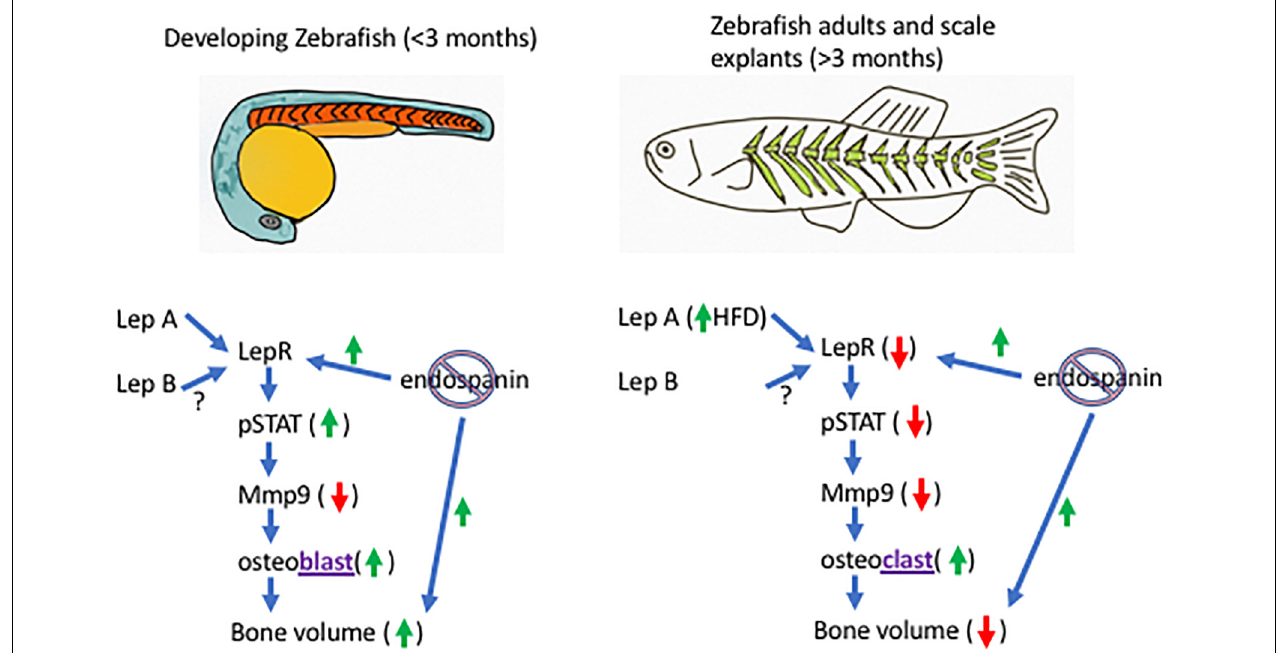
FIGURE 1 | Model of the endospanin modulation of leptin sensitivity in zebrafish. In developing zebrafish (left), endospanin knockout is predicted to increase bone volume through increased cell-surface leptin receptor expression (LepR), increase leptin signaling [through increased phosphorylation of signal transducer and activator of transcription (STAT)], decrease expression of matrix metalloproteinase 9 (Mmp9) and increase the activity of osteoblasts. In adult zebrafish (right), high fat diet is predicted to decrease bone volume through lower leptin sensitivity (decreased cell-surface leptin receptor expression), lower expression of Mmp9, and increased osteoclast activity. Endospanin knockout in adults is predicted to restore leptin sensitivity (increased LepR surface expression) and bone